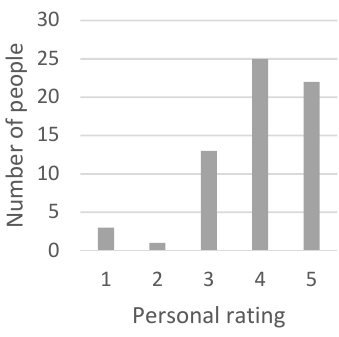
Figure A20. Rating of the source, second survey (64 individuals).